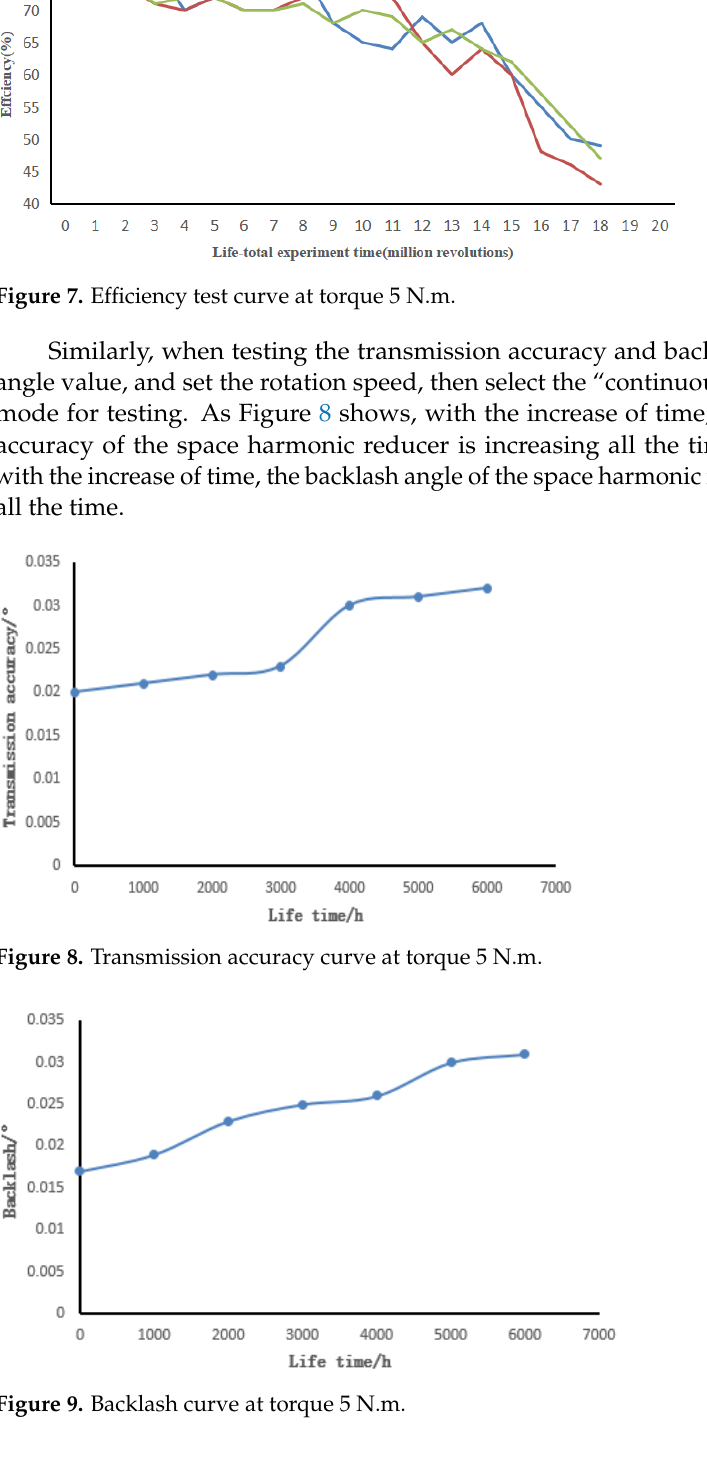
Figure 9. Backlash curve at torque 5 N.m.